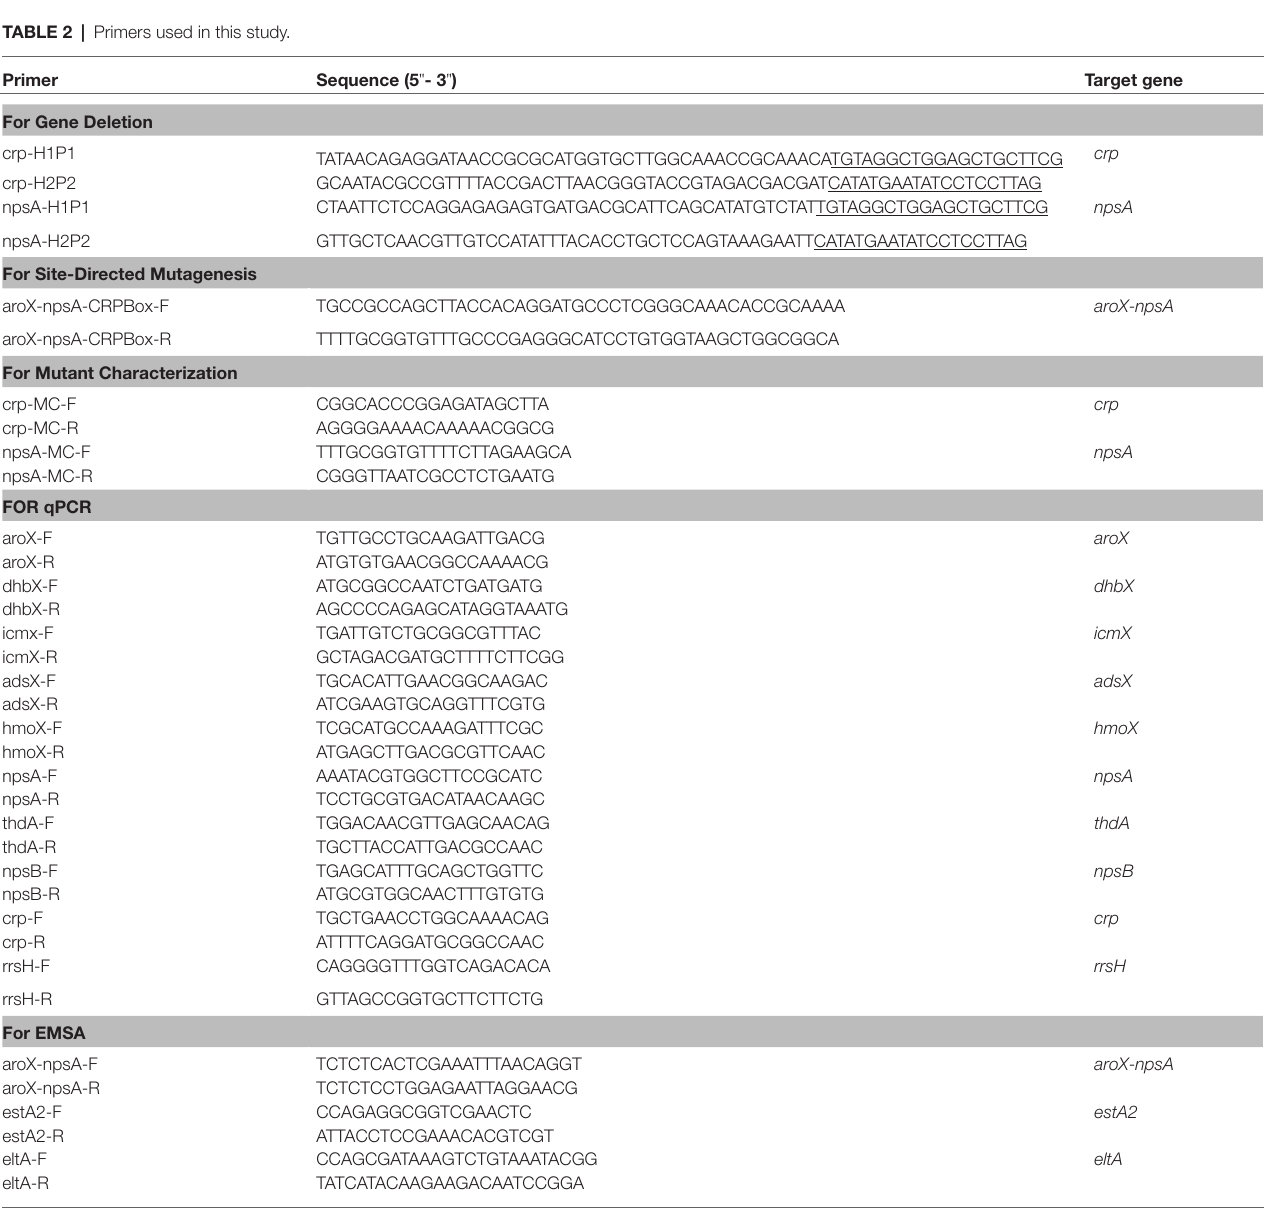
TABLE 2 | Primers used in this